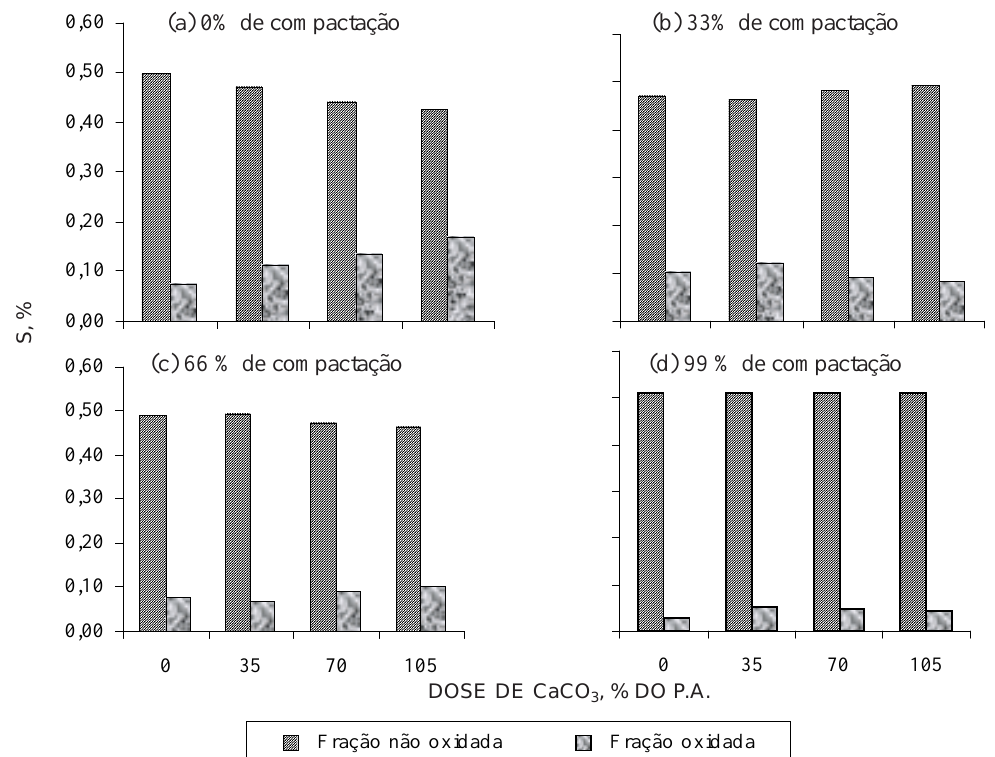
Figura 5. Teores de enxofre remanescente (fração não oxidada) no material das colunas, após a última lixiviação.